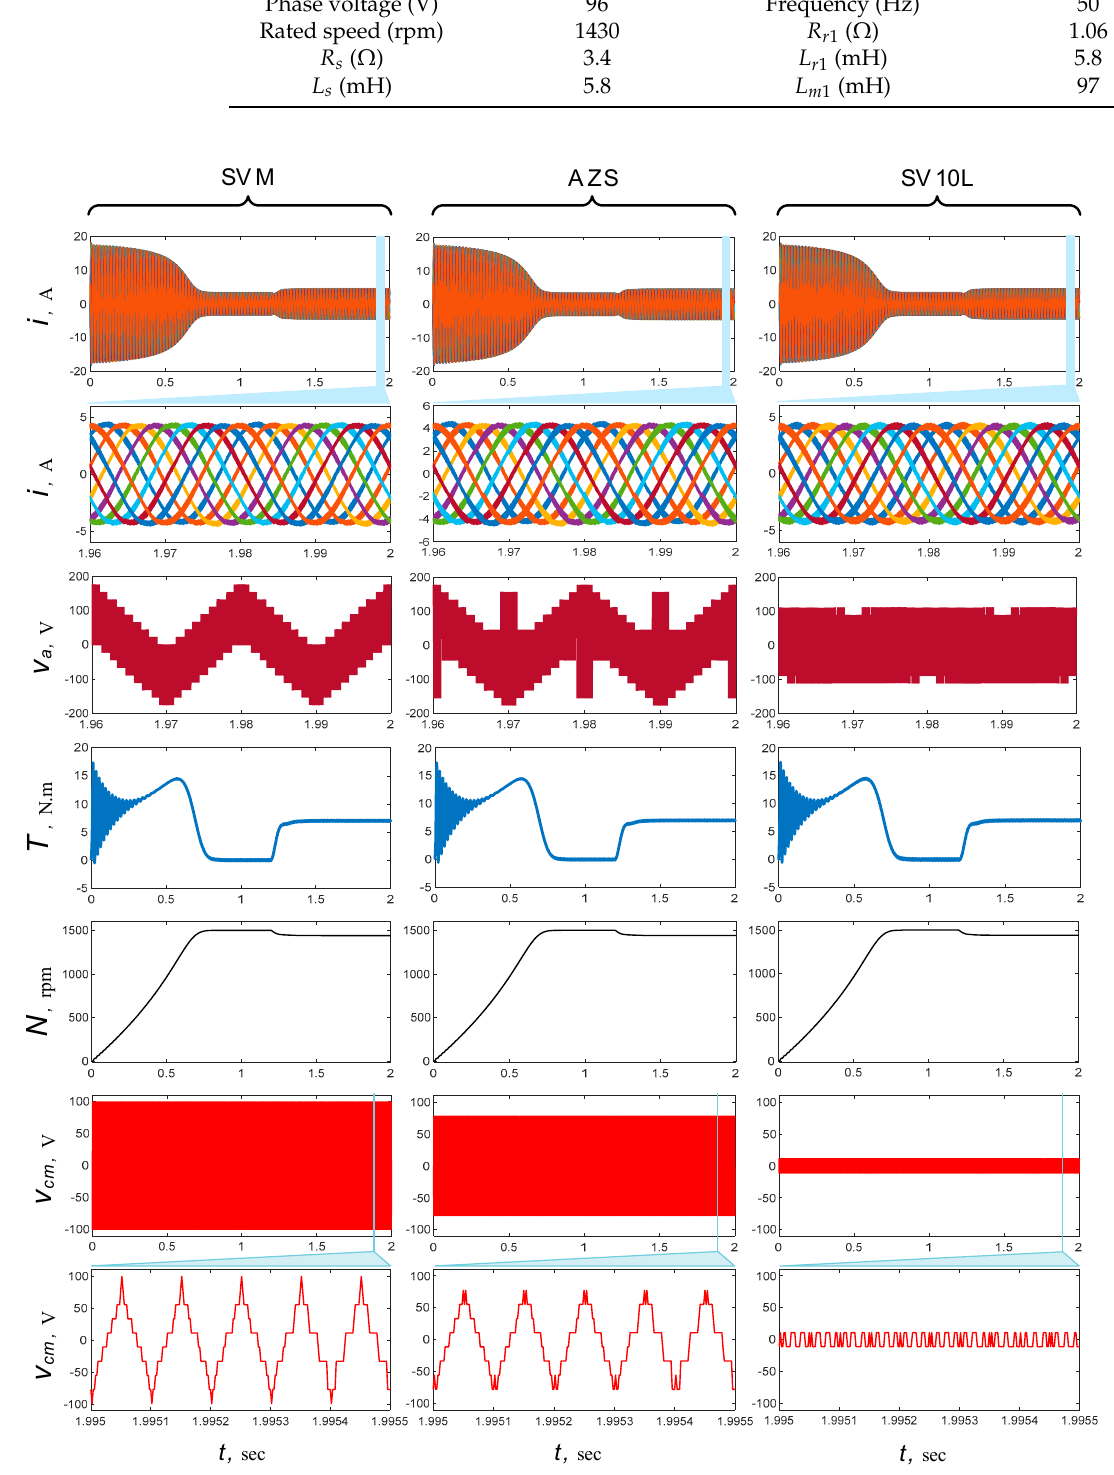
Figure 7. Simulation results for a nine-phase motor based on the conventional SVM and proposed schemes.